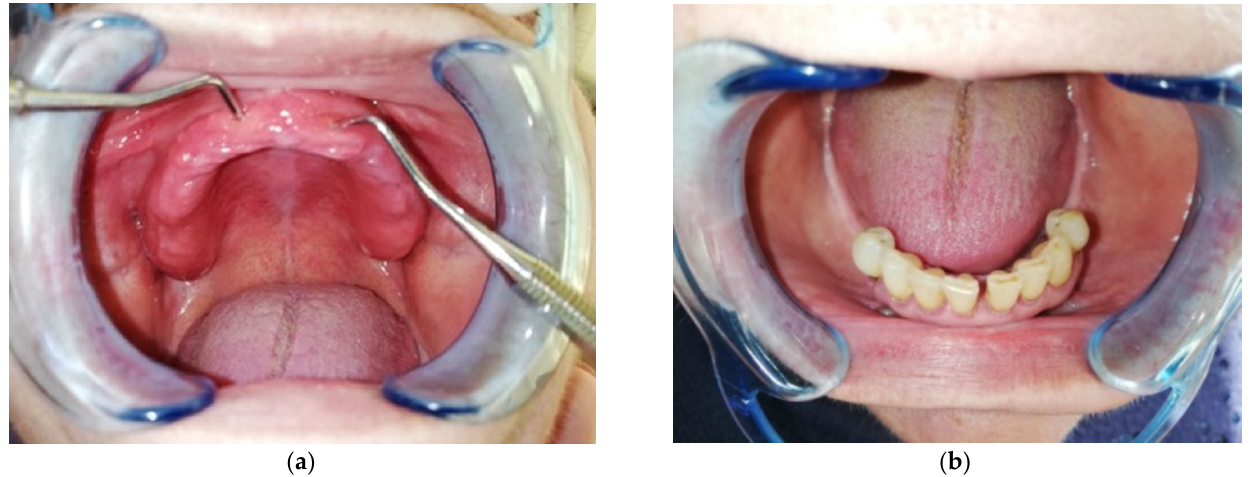
Figure 5. Prosthetic field examination ( a ) maxillary with frontalflabby ridge; ( b ) mandible Kennedy class I edentation.